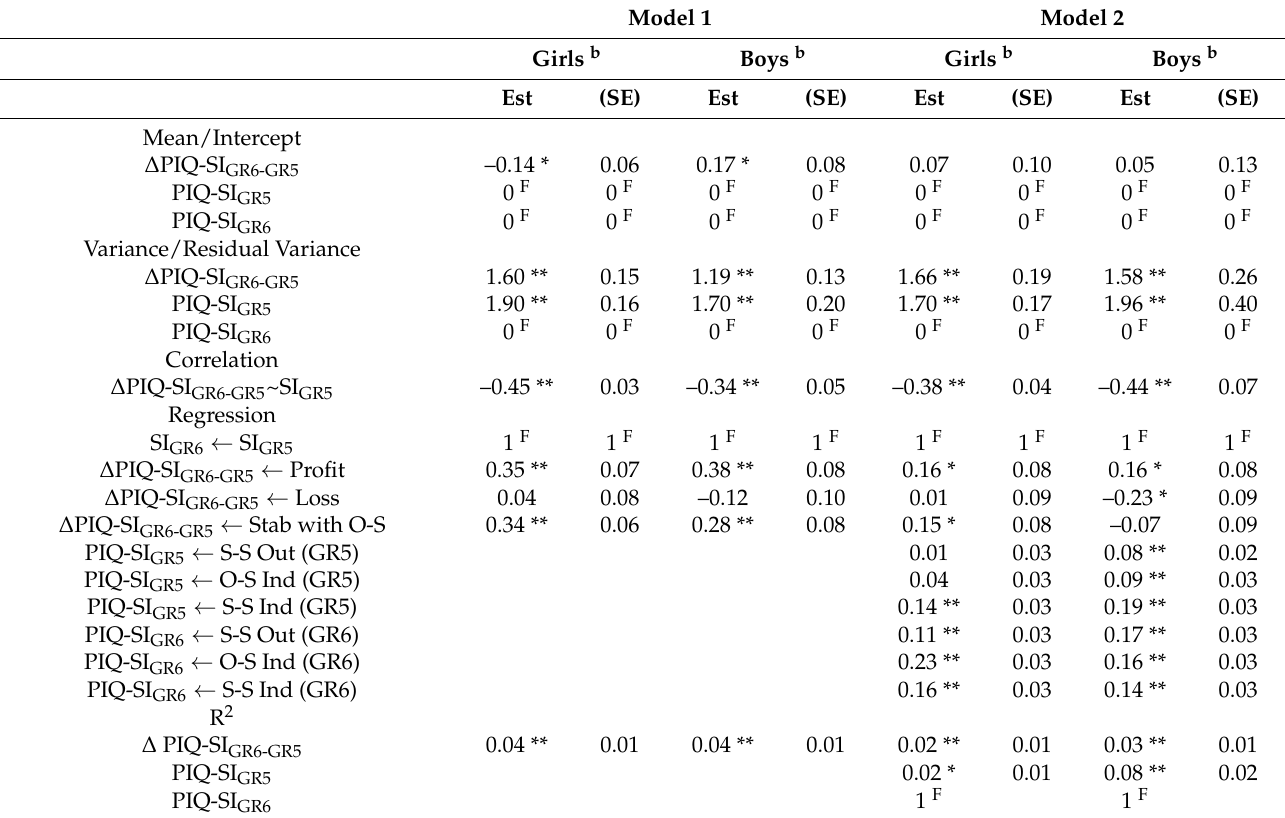
Table 5. Conditional latent difference score (LDS) models of the PIQ-SI